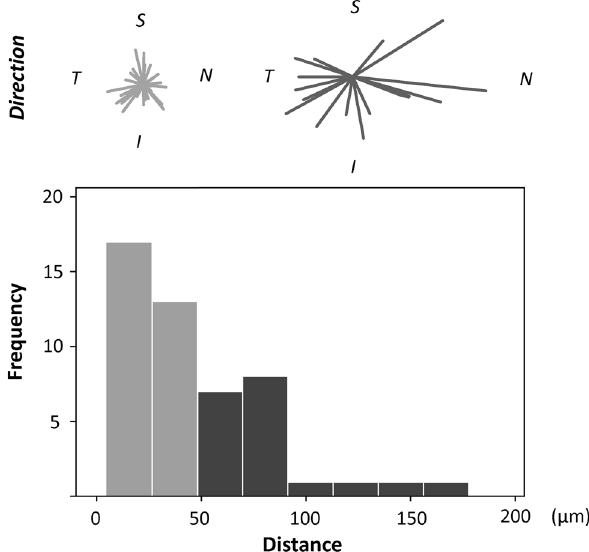
Figure 6. Total distance and direction of the highest foveal bulge point in relation to the center of the foveal avascular zone. The total (linear) distance was divided into two groups: less than 50 μm (light gray lines and bars) and greater than 50 μm (dark gray lines and bars). In the top row, the deviation of each eye in each group is indicated by the direction and length of the line. The bottom row shows the distribution of the total distance between two points. The distribution is shown to be skewed less than 50 μm. This figure was created using Stata software version 15 (StataCorp LP, College Station, TX, USA) and ImageJ software.